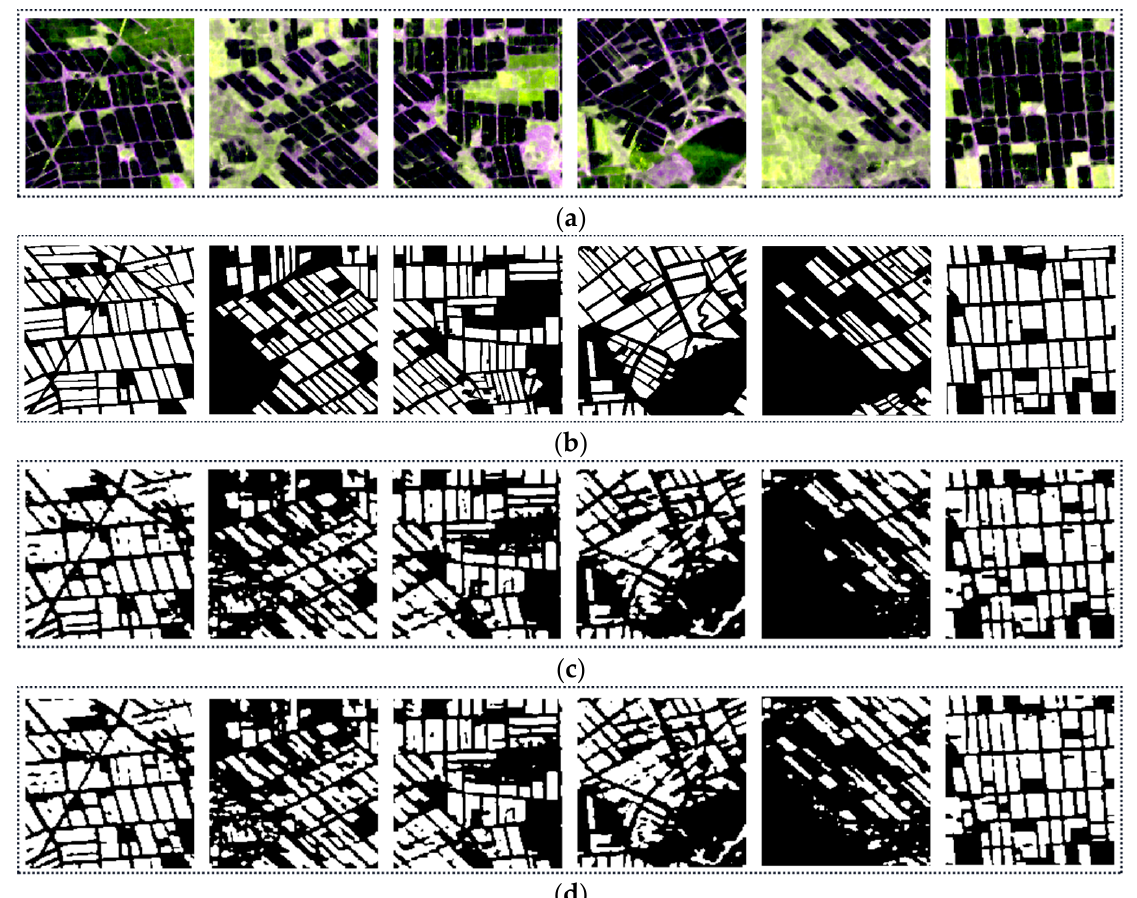
Figure 12. The classification results for 2021. ( a ) The original SAR images. ( b ) The label images. ( c ) RIAU-Net without the transfer mechanism. ( d ) RIAU-Net with the transfer mechanism. Table 7. The results of the RIAU-Net model with and without the transfer mechanism.